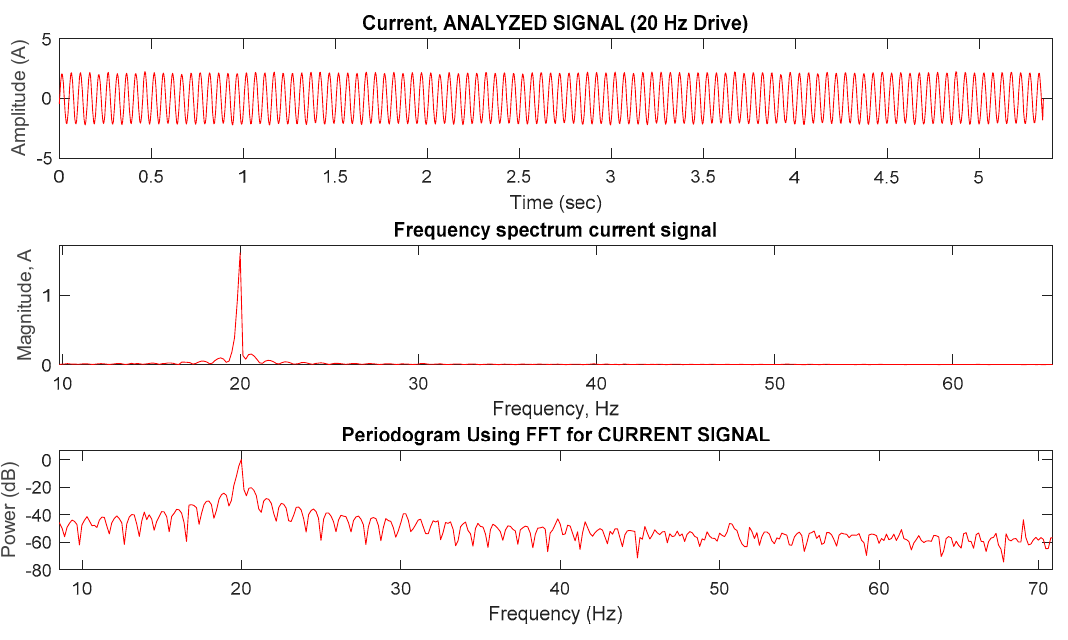
Figure 11. FFT analysis of current signal measurement of motor line current of phase A, frequency spectrum, and periodogram at 30 Hz speed operation.